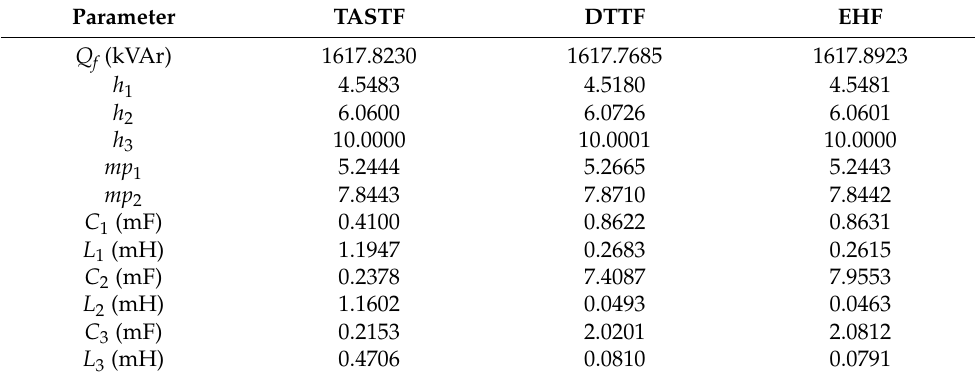
Table 4. Optimized values of the TASTF and DTTF obtained with ARO.